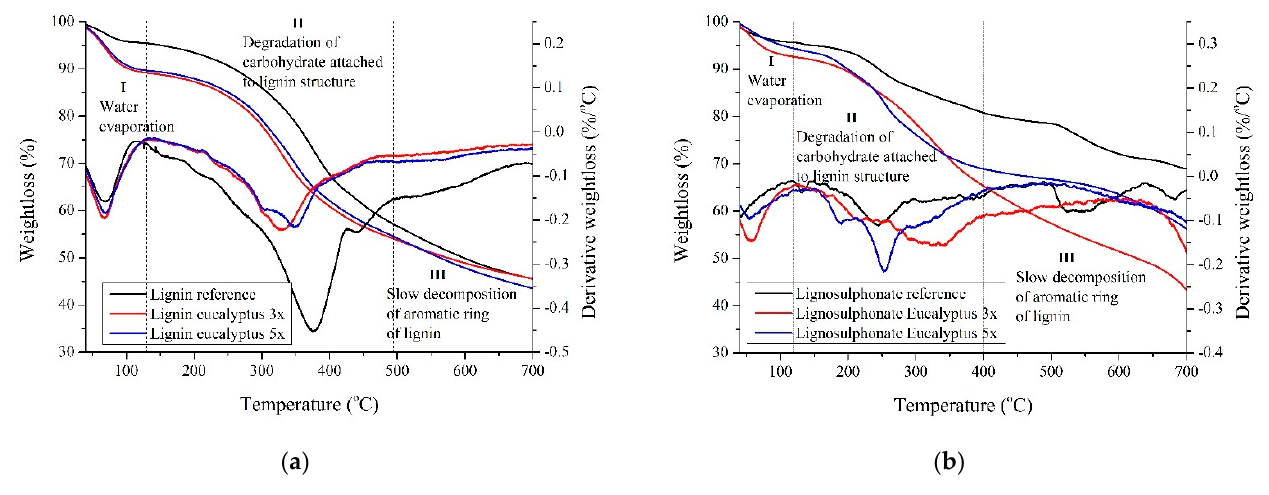
Figure 6. TGA and DTG of lignin ( a ) and lignosulphonate ( b ).